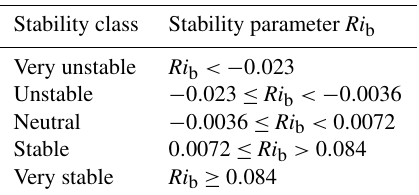
Table 4. In accordance with Table 2 the five reduced stability classes are